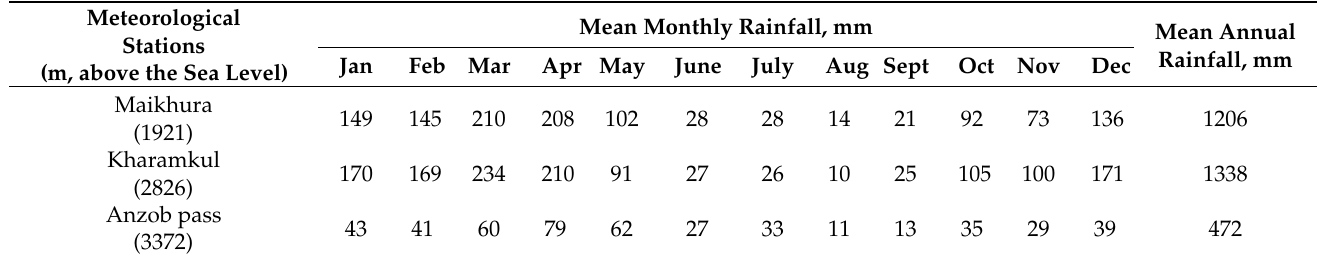
Table 1. Distribution of the mean monthly precipitations in the study area.